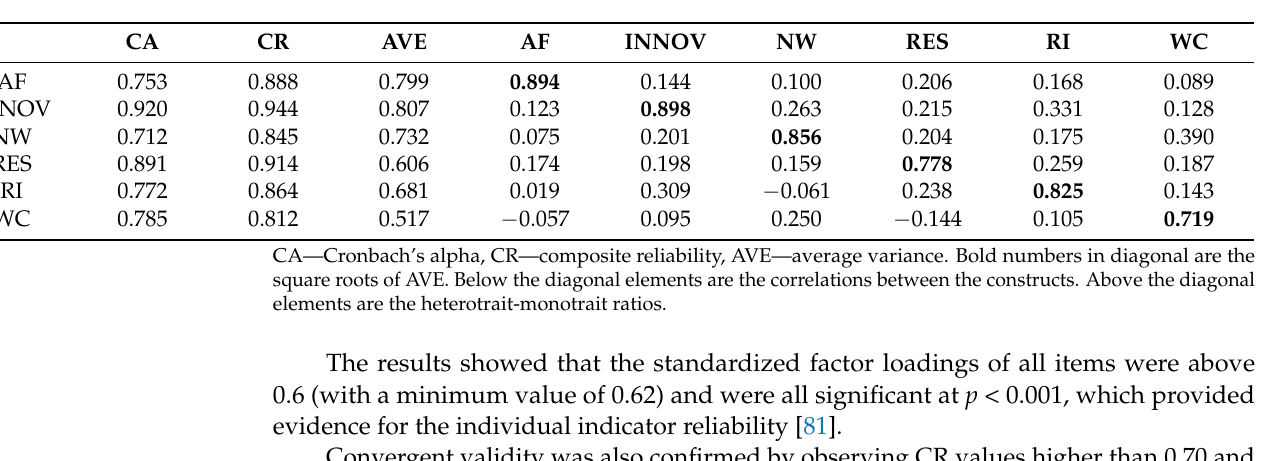
Table 1. Cronbach’s alpha, composite reliability, average variance, correlations, and discriminant validity.